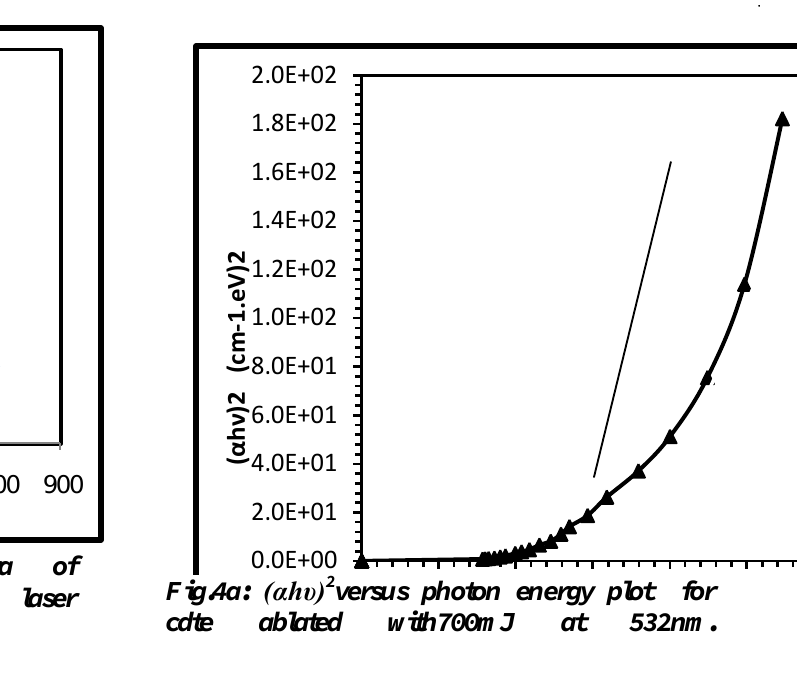
Fig.4a: (αhυ) 2 versus photon energy plot for cdte ablated with700mJ at